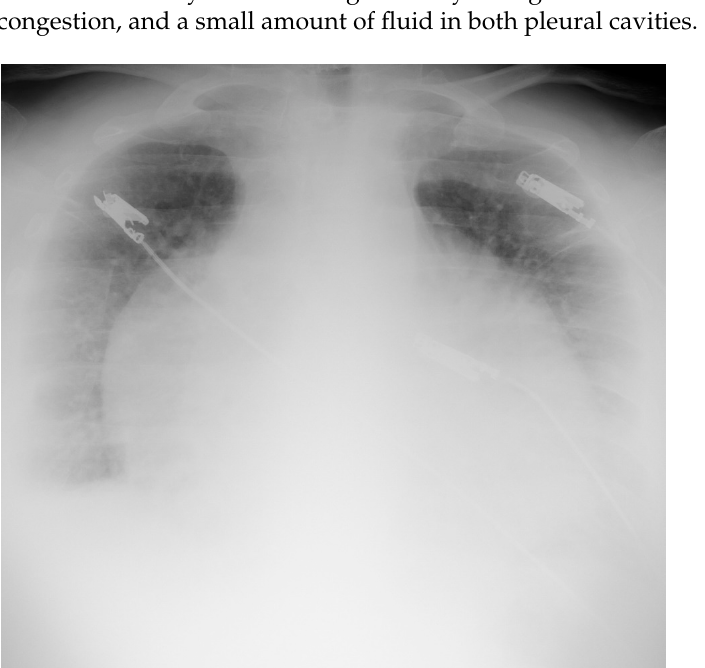
Figure 1. Chest radiograph in supine position shows significantly enlarged cardiac silhouette, signs of pulmonary congestion, and increased homogeneous density superimposed over the lungs due to bilateral pleural effusion.